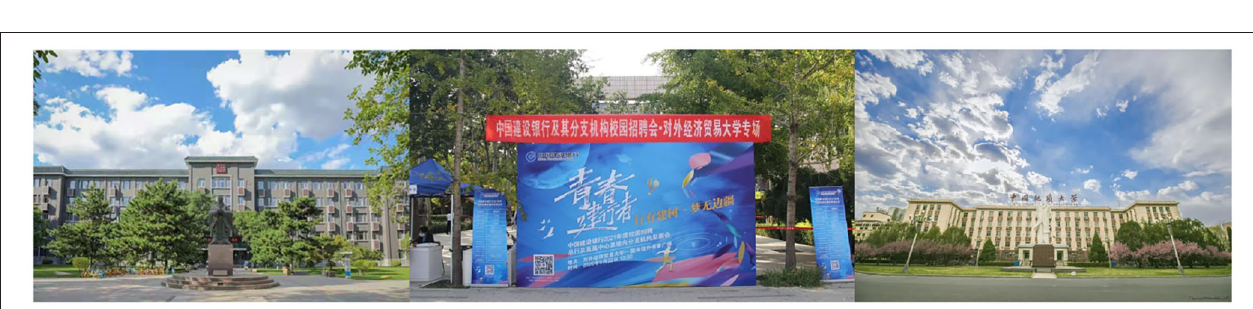
FIGURE 2 | The quality of the three pictures in the OAPQD decreases gradually from left to